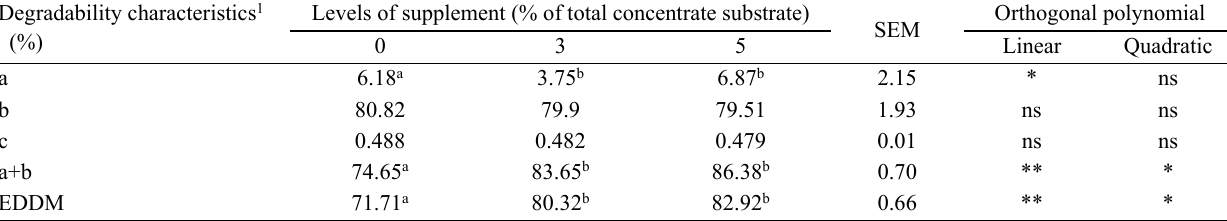
Table 4. Effect of soybean meal fermented milk (SBMFM) supplementation on dry matter disappearances